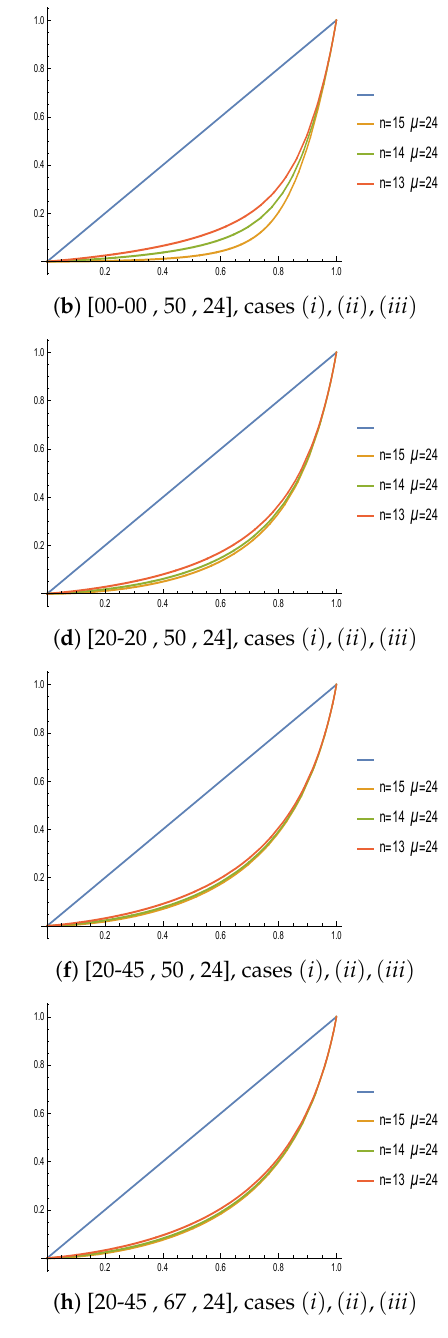
Figure 3. Each of the panels ( a – h ) displays the Lorenz curves relative to the income distribution of the model quoted in the relative caption, in the three cases ( i ) , ( ii ) , ( iii ) . It is evident from all panels that the Gini coefficient, and correspondingly economic inequality, diminishes when a basic income is